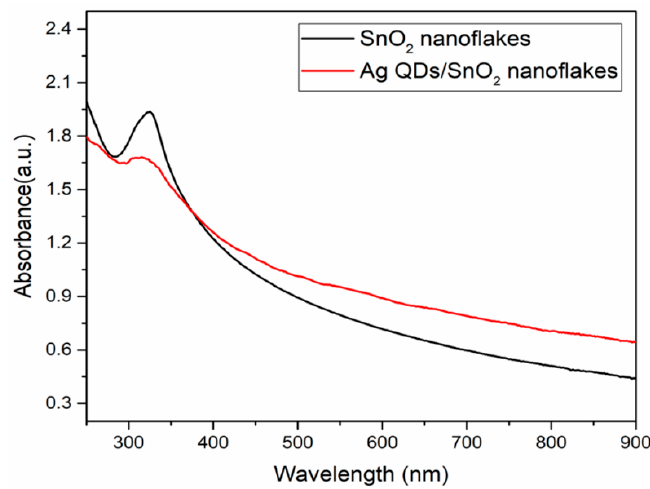
Figure 7. UV–Vis absorption spectra of the SnO 2 and Ag QDS/SnO 2 nanostructures .